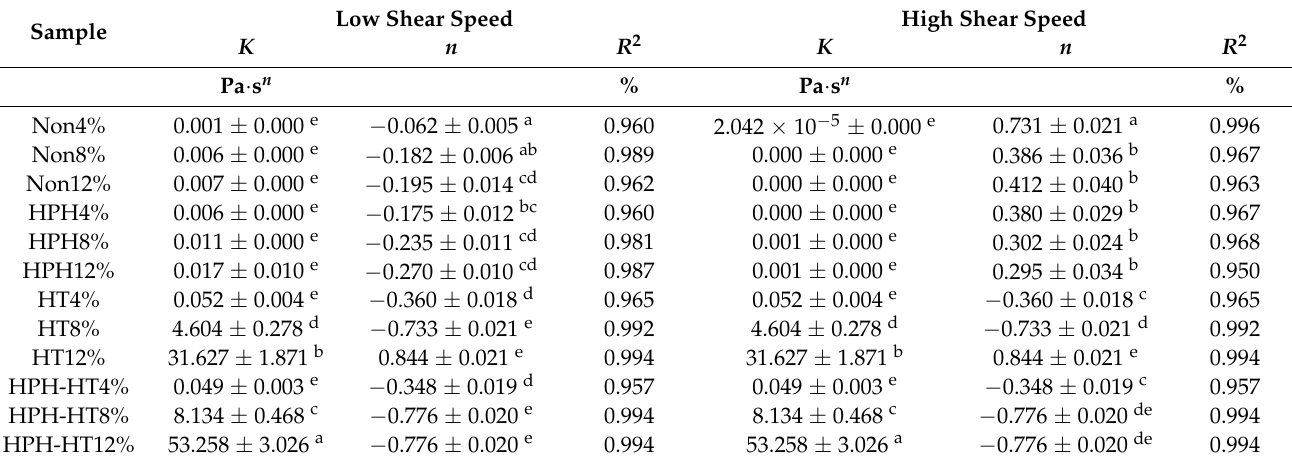
Table 4. Effect of different treatment on the fitting coefficient consistency factor k and flow behavior Table 4. E ff ect of di ff erent treatment on the fi tt ing coe ffi cient consistency factor k and fl ow behavior index n of DCF dispersion at different concentrations in steady state index n of DCF dispersion at di ff erent concentrations in steady state shear.